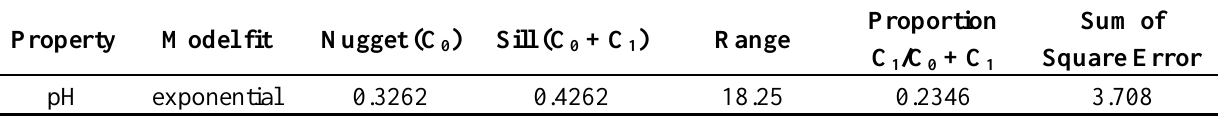
Table 4. Parameters of the exponential semivariogram model used to develop full-point pH